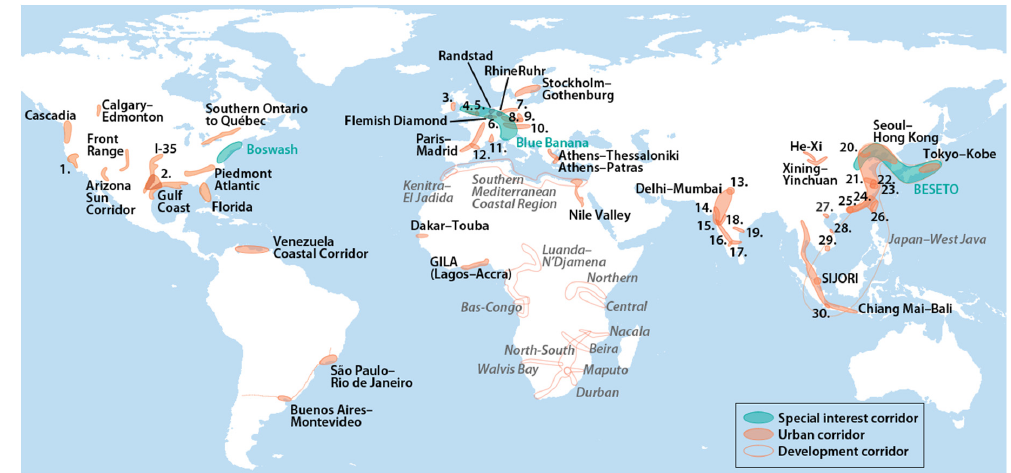
Figure 4. Urban corridors identified in the literature review. 1. Northern California, 2. Texas Triangle, 3.